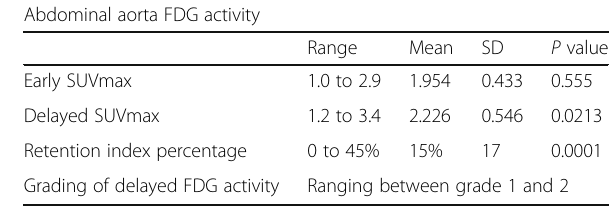
Table 7 Descending abdominal aorta FDG dual point quantitative parameters in the 50 patients of study population